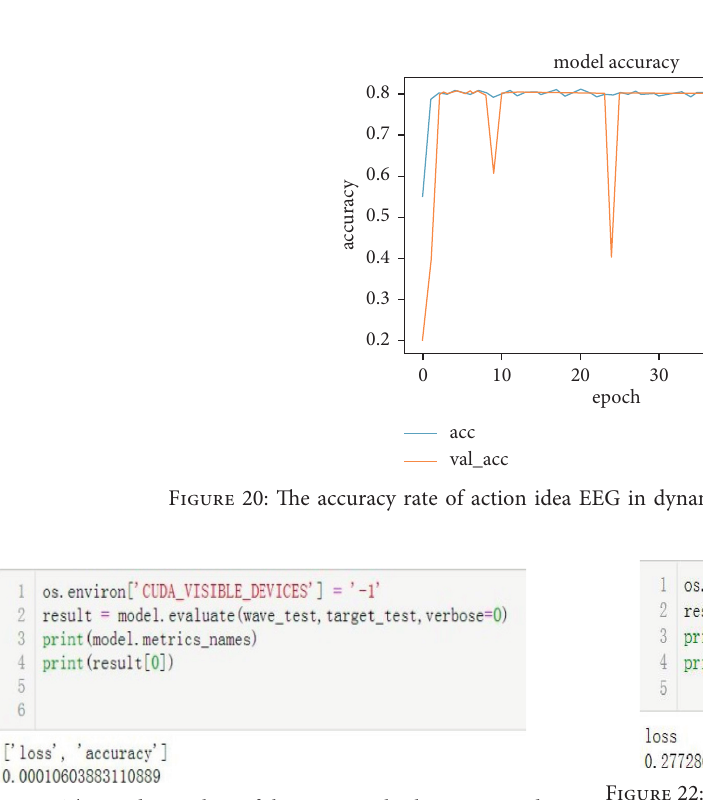
Figure 21: The prediction loss of the test sample about action idea EEG in static state.